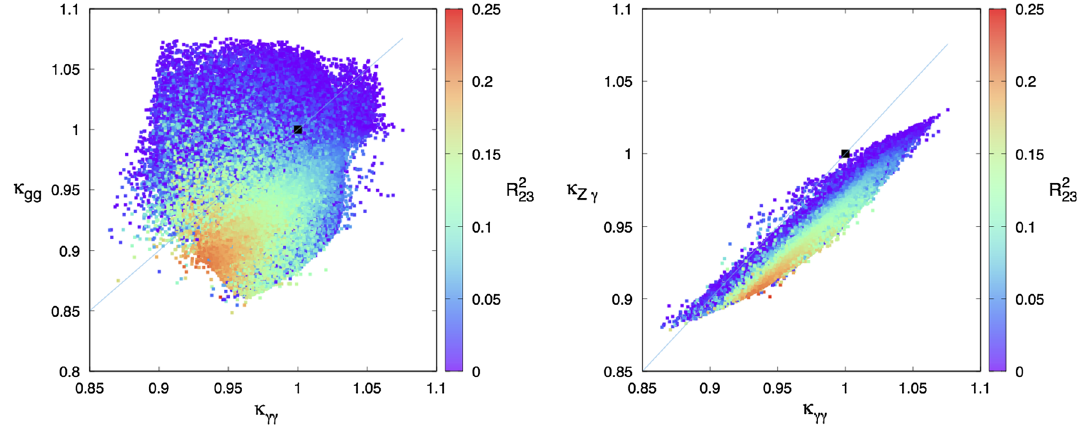
and between κ h 2 γγ and κ h 2 23